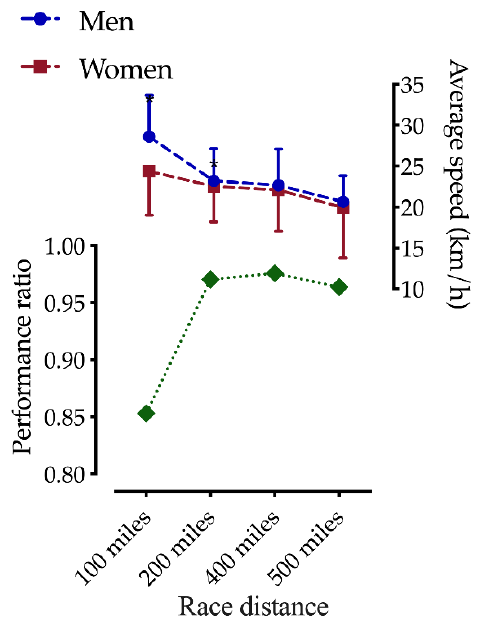
Figure 3. Comparison of performance level between men and women participating in ultra-distance cycling (100 – 500 mile races). * Statistical difference between men and women. Data expressed as means and standard deviations.